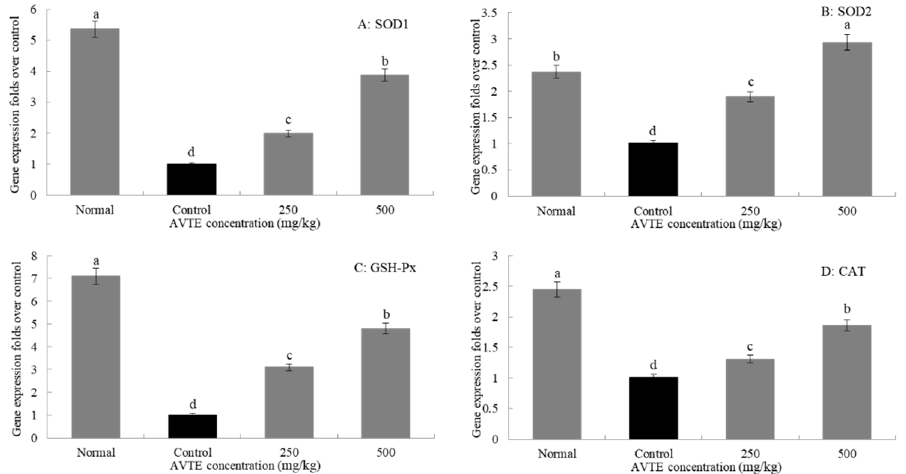
Figure 5. Effects of AVTE on the mRNA expression of SOD1, SOD2, GSH-Px, and CAT in liver tissue of the mice. a–d Mean values with different letters in the same bar graph are significantly different ( p < 0.05) according to Duncan’s multiple range test.